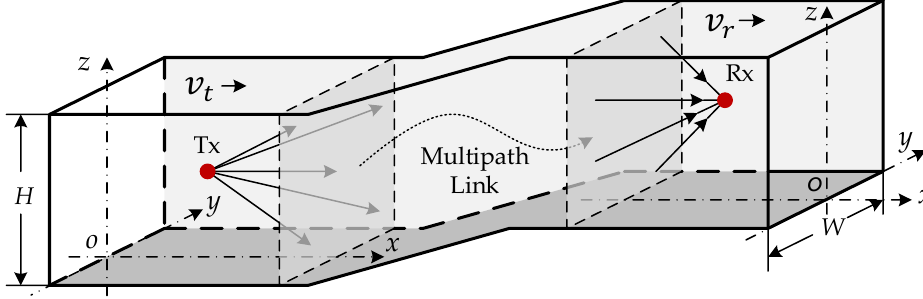
Figure 1. Three-dimensional map of T2T communication in tunnel scenario.